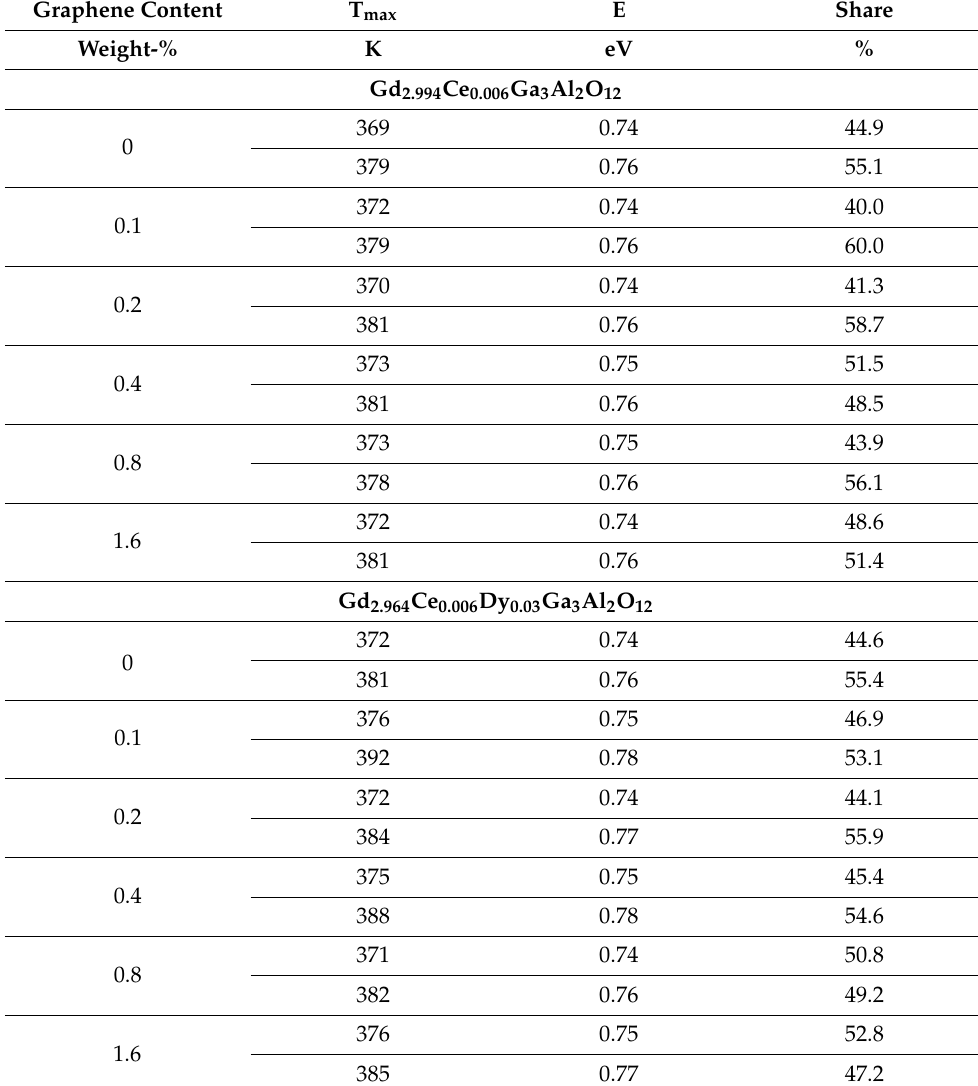
Table 4. TL glow curve maxima and energy of the traps calculated for Gd 2.994 Ce 0.006 Ga 3 Al 2 O 12